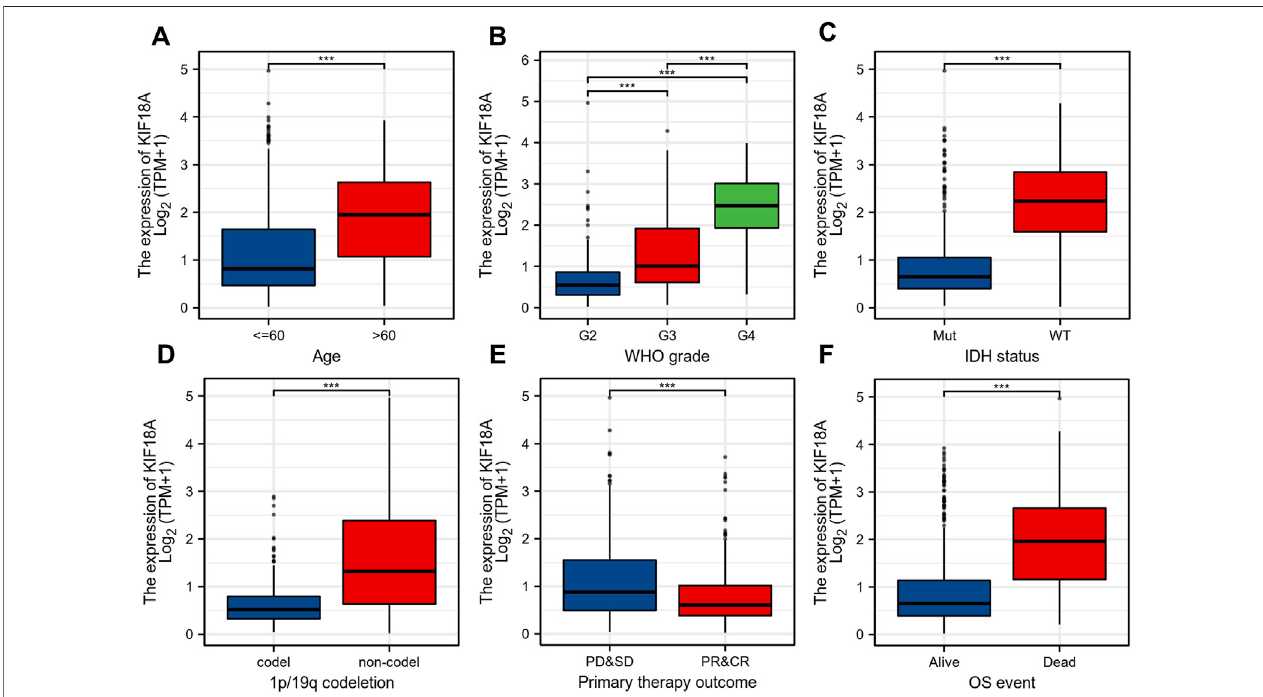
FIGURE 2 | Correlations between the KIF18A mRNA expression and different indicators of poor clinical prognosis of glioma patients. (A) Age, (B) World Health Organization (WHO) grade, (C) IDH status, (D) 1p/19q codeletion, (E) primary therapy outcome, (F) OS event. (*** p < 0.001).